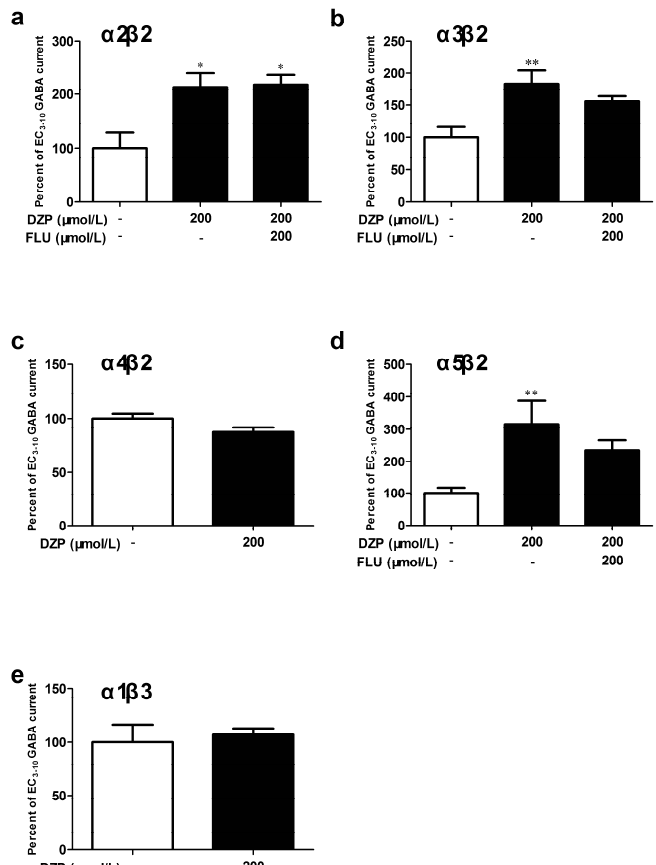
Figure 4. Modulatory effects of diazepam on different αβ receptors. GABA (EC 3–10 , 1 μ mol/L